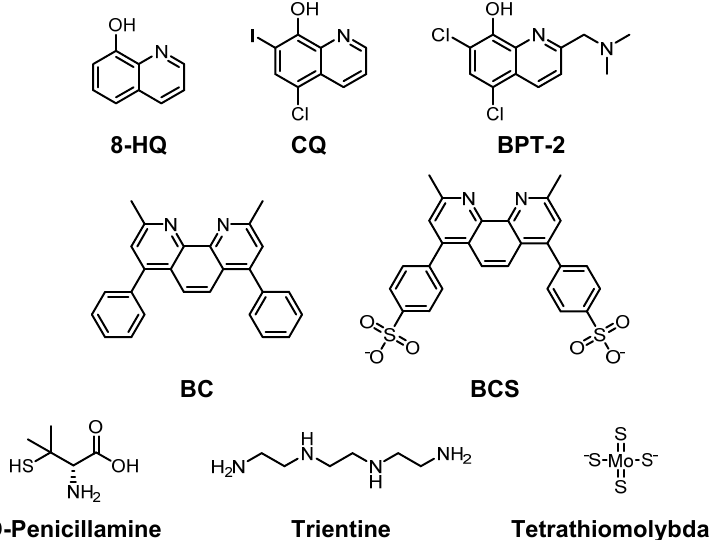
Figure 2. Selected Cu(I/II)-targeting molecules developed to maintain Cu(I/II) homeostasis. Top row: 8-hydroxyquinoline ( 8-HQ ) and its derivatives, clioquinol ( CQ ), 5-chloro-7-iodoquinolin-8-ol, and BPT-2 , 5,7-dichloro-2-[(dimethylamino)methyl]quinolin-8-ol; middle row: bathocuproine ( BC ), 2,9-dimethyl-4,7-diphenyl-1,10-phenanthroline, and bathocuproine disulfonate ( BCS ), 4,40-